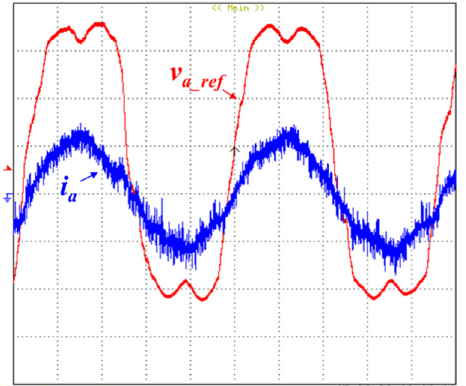
Figure 32. Reference signal and current in phase a when the electric machine operates with a 45 Nm mechanical load (current: 20 A/div; voltage: 2 V/div; time: 10